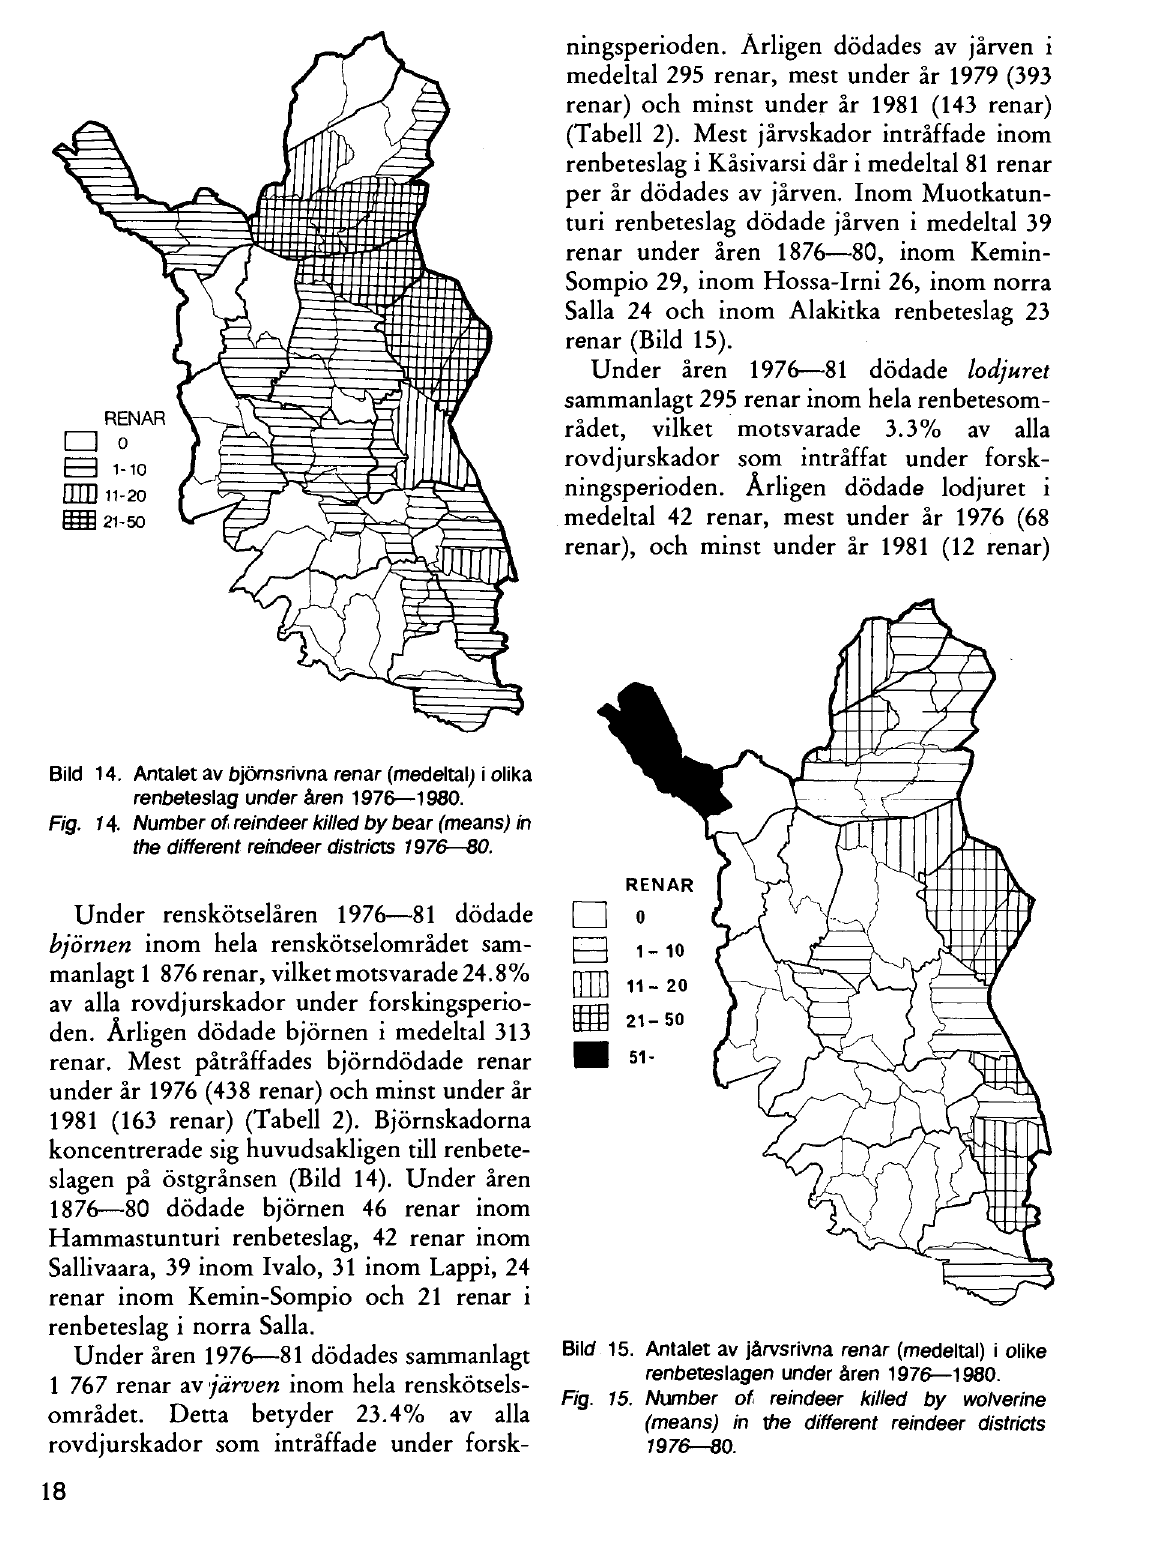
Fig. 15. Number of reindeer killed by wolverine (means) in the different reindeer districts